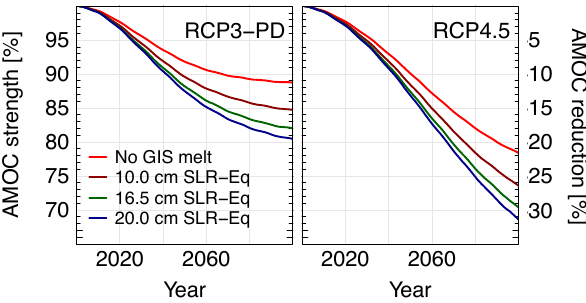
Fig. 5. Projections of the probabilistic ensemble median AMOC- reduction for different Greenland meltwater influx scenarios for the RCP3-PD (left) and the RCP4.5 (right) emission pathway. Additional freshwater forcings correspond to 10, 16.5 and 20cm Greenland contribution to global SLR by 2100.